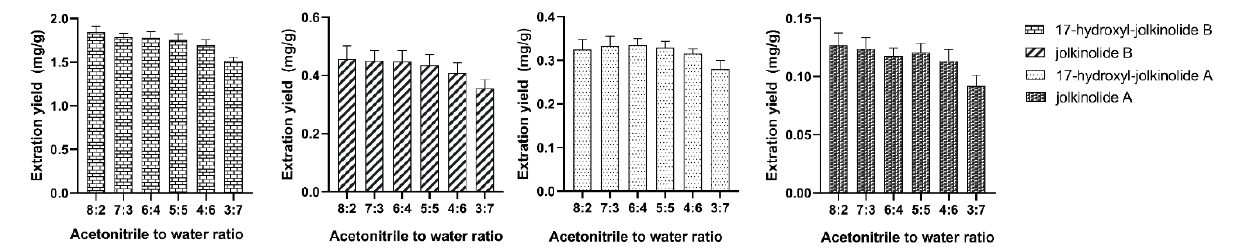
Figure 8. The effect of acetonitrile-to-water ratio.